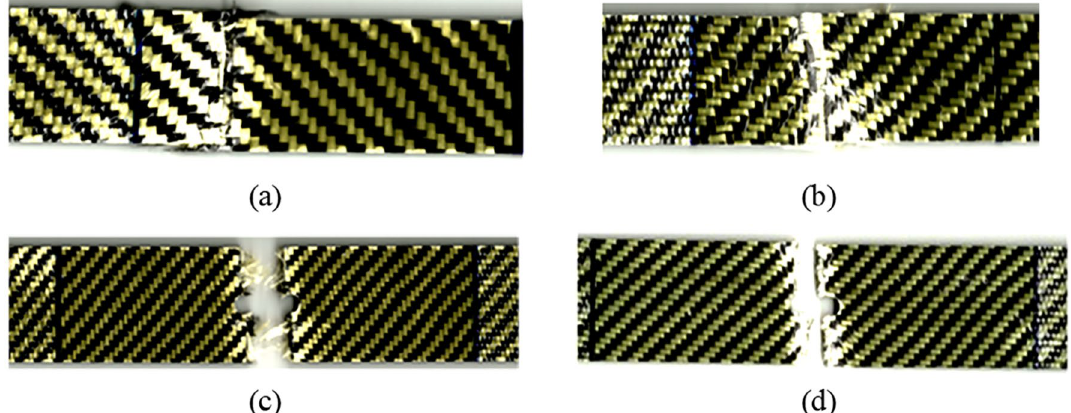
Figure 7. Mechanical fracture characteristics of the specimens: (a) CLCO; (b) CLKO; (c) CLCH; (d) CLKH.